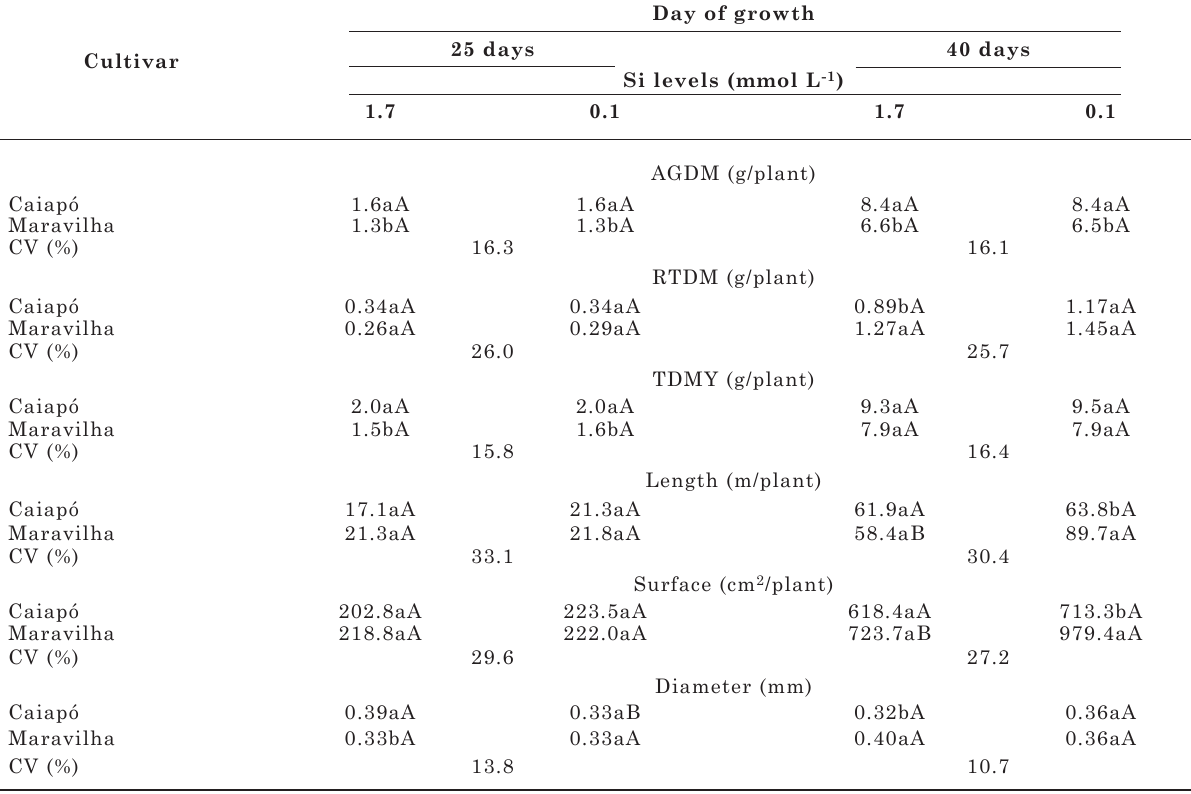
table 2. Dry matter weight of the aerial part (DmaeP), root (Dmrt), and total dry matter yield (tDmy), root length, surface, and diameter of rice cultivars at different silicon concentrations in the nutrient solution 25 and 40 days after transfer into the growth solution